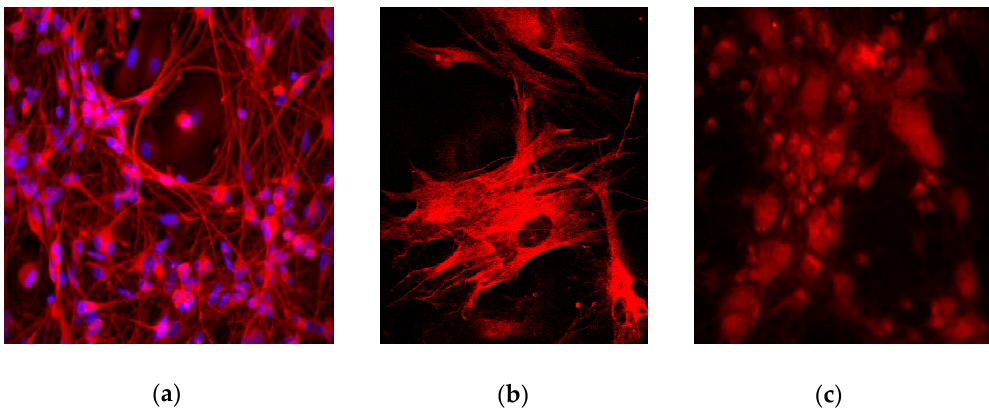
Figure 2. Immunocytochemical staining and fluorescence confocal microscopy of primary human glioblastoma culture fixed at 80% confluency. Glioma cells were stained with a primary anti-glial fibrillary acidic protein (GFAP) antibody and secondary Texas Red X. Cell nuclei were stained with DAPI. ( a ) Stained cultures at 40 × objective. ( b ) Stained cultures at 63 × objective. ( c ) Immune cell stained with anti-CD11b (red) present within a glioblastoma culture imaged with a 40X objective. Troubleshooting